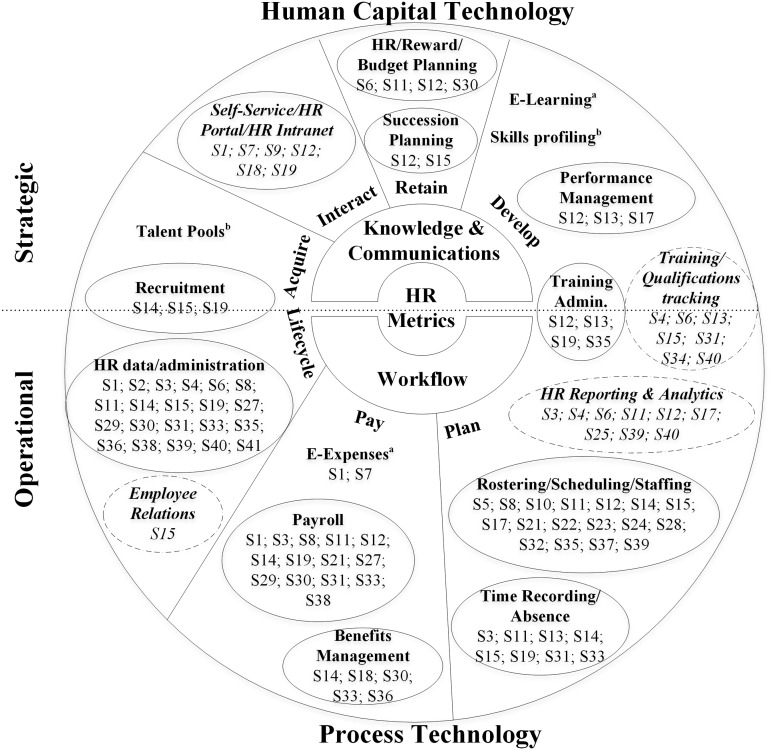
HRM practices examined in the included studies. aOut of scope of this review (please see9). bNot mentioned in any of the qualifying studies. Solid line ovals: existing Foster’s e-HRM landscape categories. Dashed line ovals, text in italic: categories added to Foster’s e-HRM landscape.